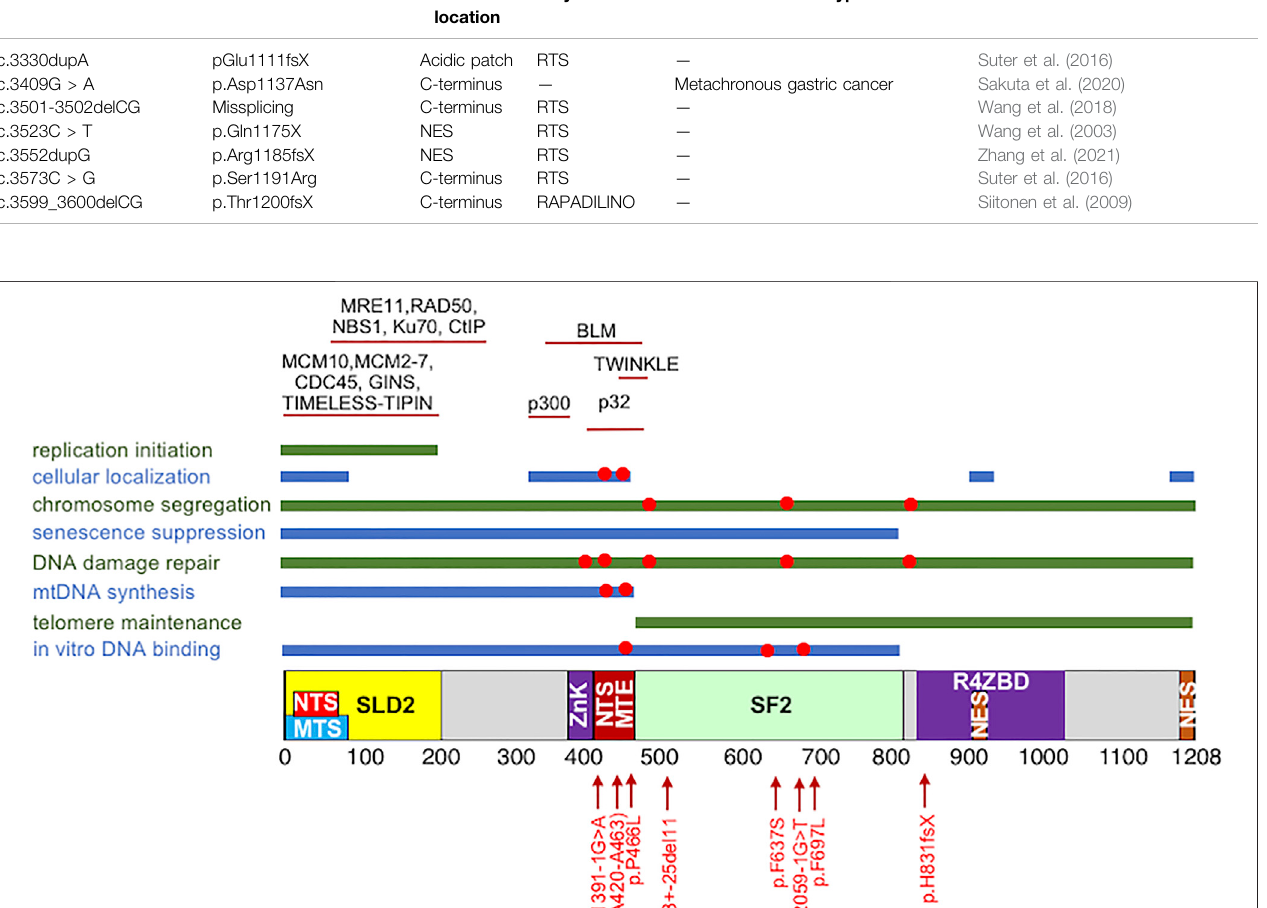
Frontiers in Molecular Biosciences |